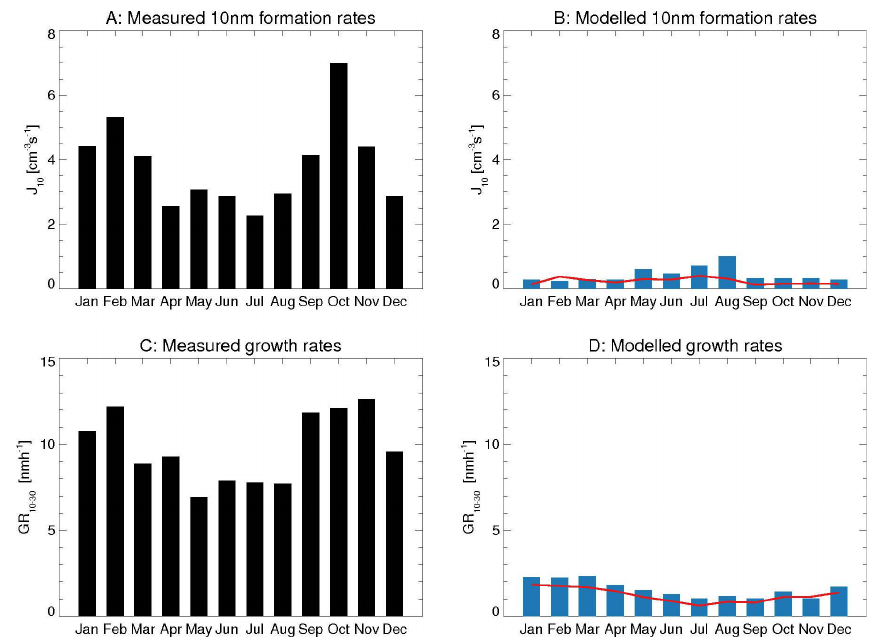
Fig. 6. Observed (left) and modelled (right) particle formation and growth rates. Red curves as in Fig.